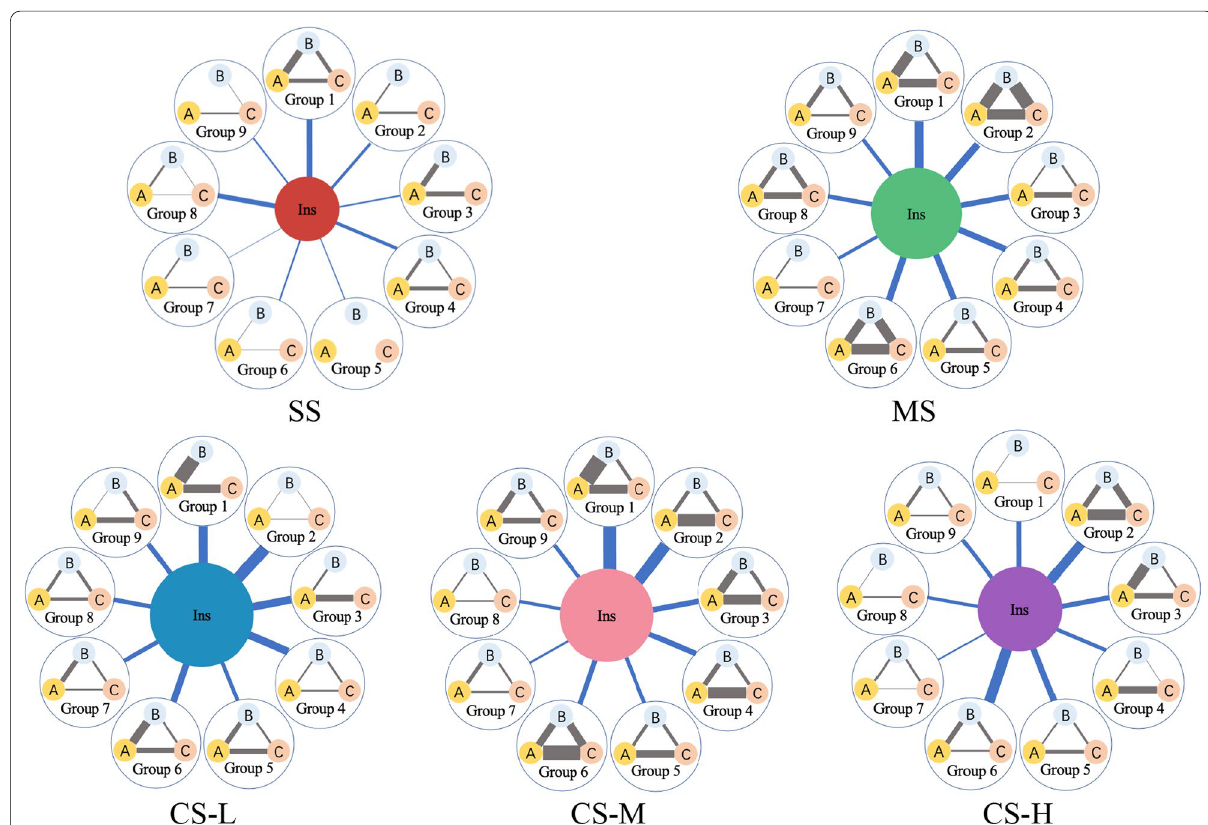
Fig. 6 The social networks of the five instructor scaffoldings. Node sizes of instructor represented the frequencies of instructor scaffolding; the link widths between two student nodes represented the interaction